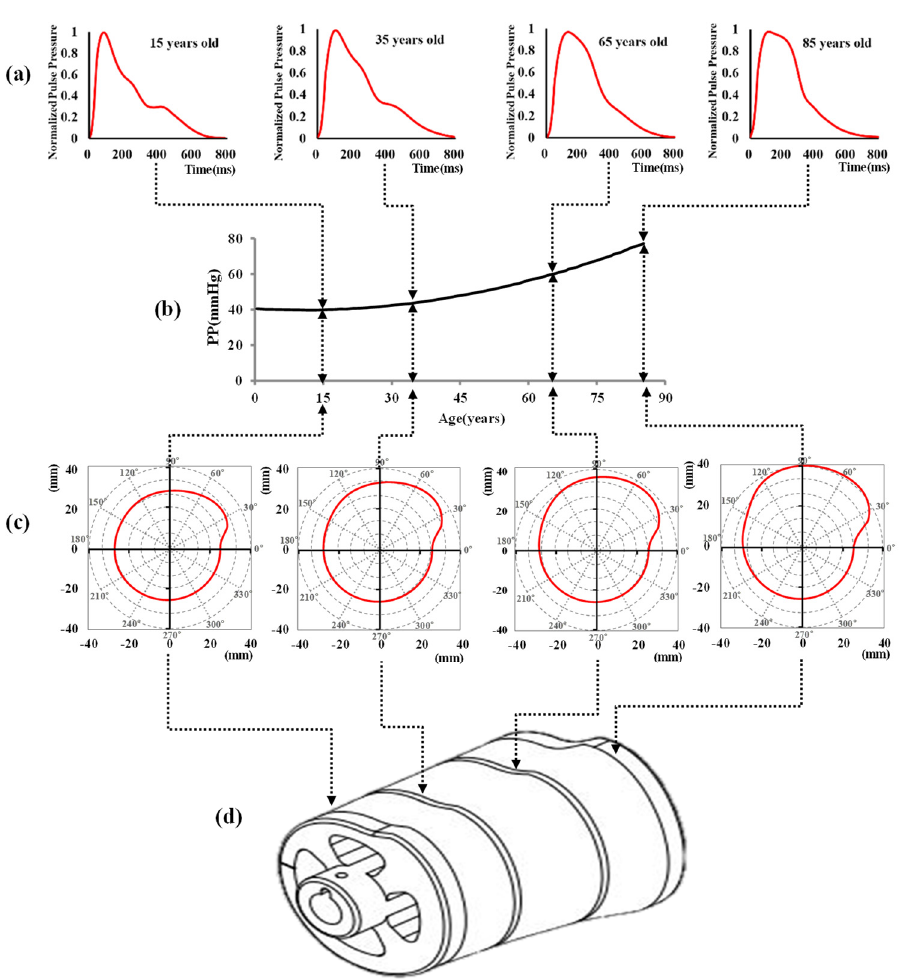
Figure 1. The proposed cam design based on age-specific pulse pressure waveforms: ( a ) Normalized average pulse pressure waveforms for each age group; ( b ) Polynomial regression curves fitted to mean pulse pressure by age group (Reprinted with permission from Ref. [27]. 2010, Wolters Kluwer Health, Inc.); ( c ) A circular cam-type graph created by converting one cycle of the average pulse pressure waveform to 360 degrees; ( d ) The cam design created by regressively integrating four age-specific cam